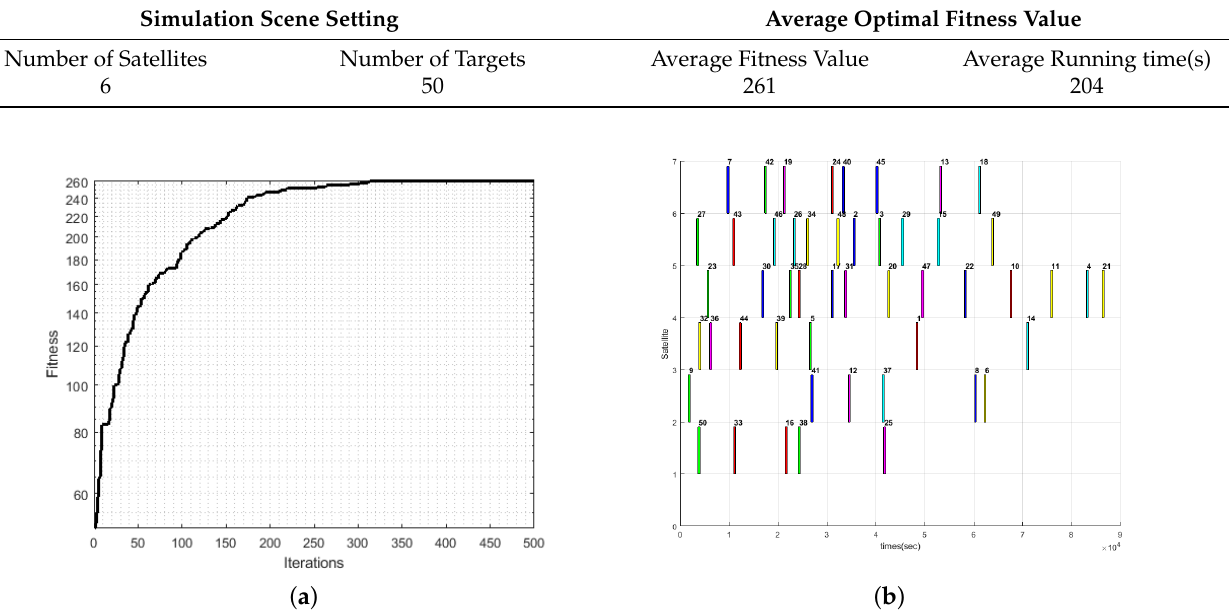
Table 3. Typical results of MSCATP based on H-GASA.